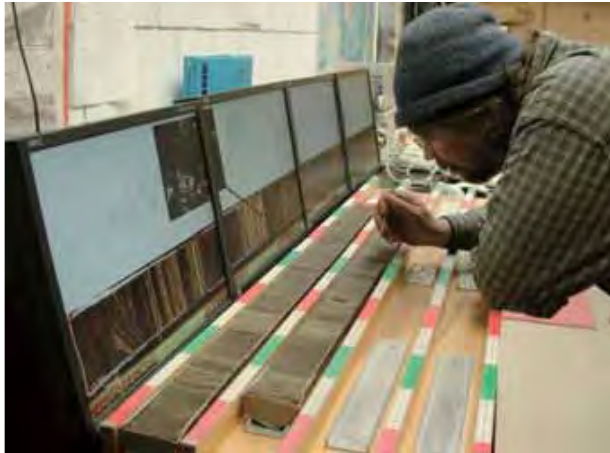
Figure 3. CoreWall setup for visual core description in laboratory.